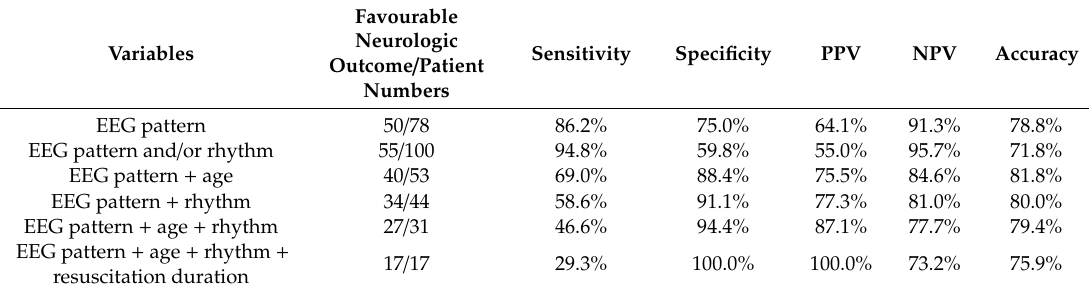
Table 4. Predictive value of clinical and EEG findings for favourable neurologic outcome (favourable neurologic outcome event / total patients = 58 /